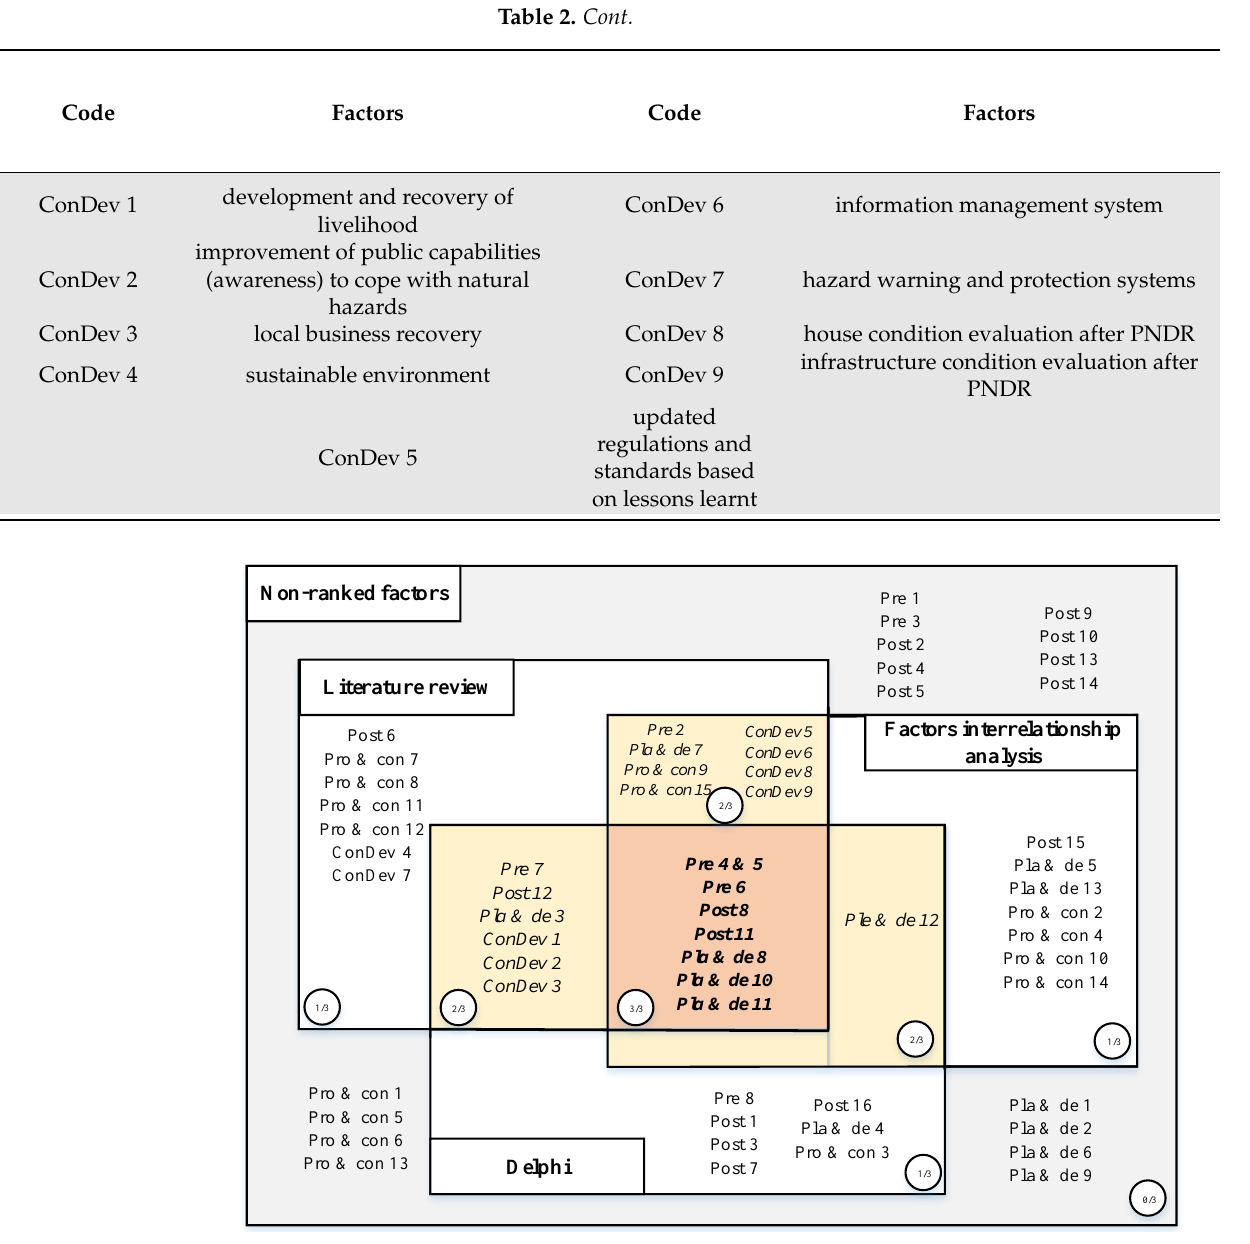
Figure 2. Results’ clusters generated by triangulation methodology. (3/3) Full agreement. (2/3) 2/3 agreement. (1/3) 1/3 agreement. (0/3) Non-agreement